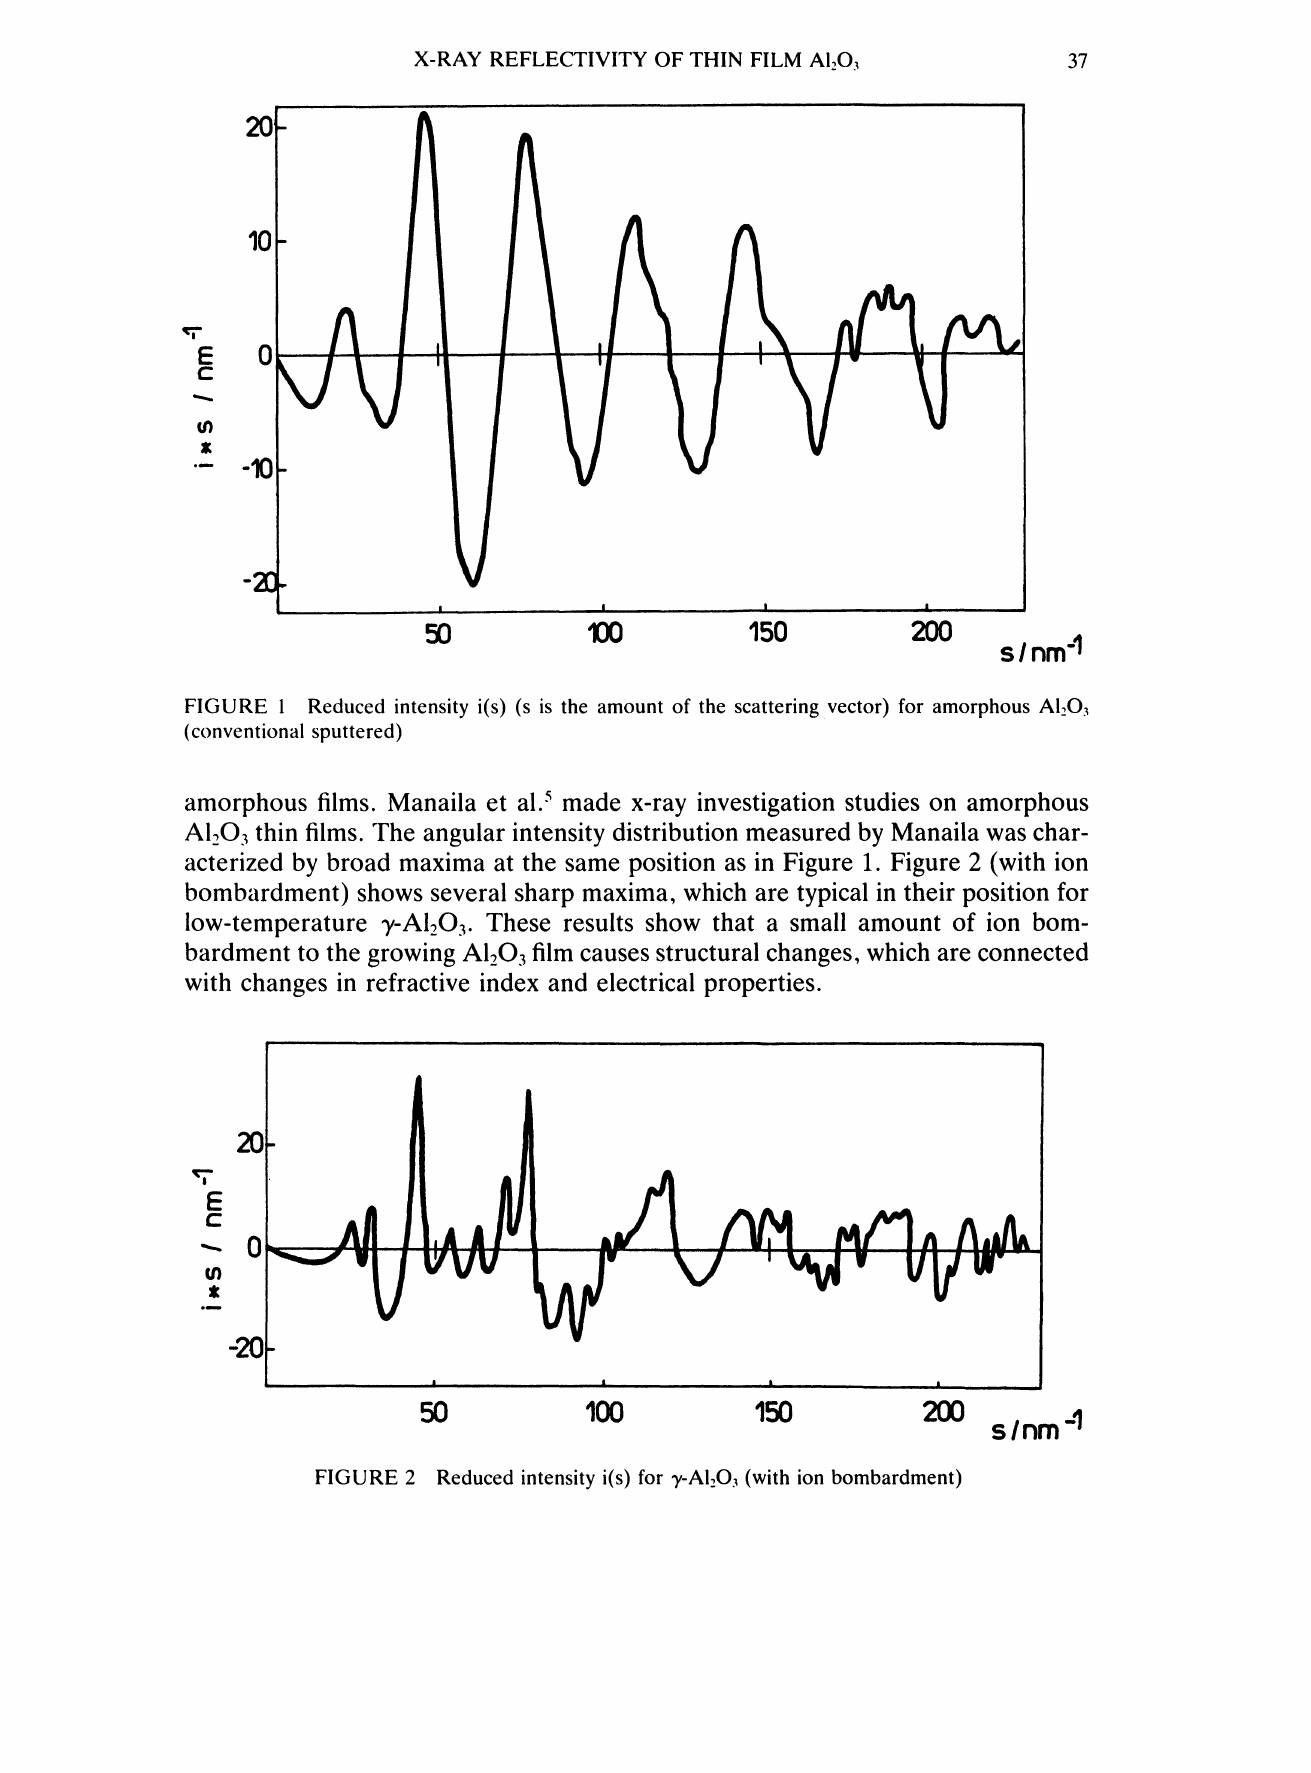
FIGURE 2 Reduced intensity i(s) for 7-A1_,O3 (with ion